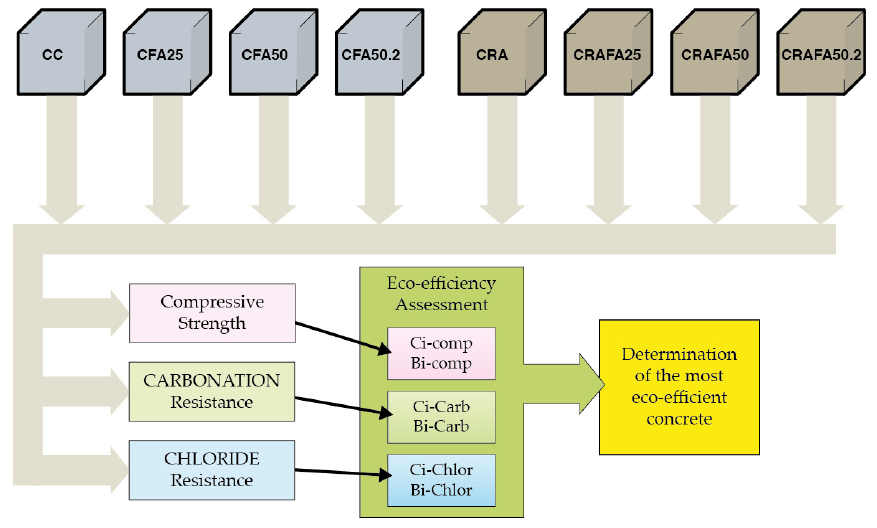
Figure 4. Flowchart of the test procedure carried out.